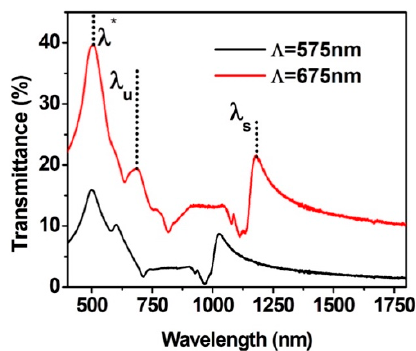
Figure 3. Optical transmission spectra of the array of holes recorded in Au film with 60 nm of thickness, periods Λ = 575 nm (black) and 675 nm (red) and diameter of 230 nm and 250 nm, respectively. The red curve is off-set along the vertical axis in order to separate the curves for comparison purpose. Table 1. Data from experimental transmission spectra for arrays of holes in air for di ff erent periods, film thickness and hole diameter. Λ : periodicity; T: thickness; D: diameter; λ u : upper-metal resonance peak; λ s : metal-substrate resonance